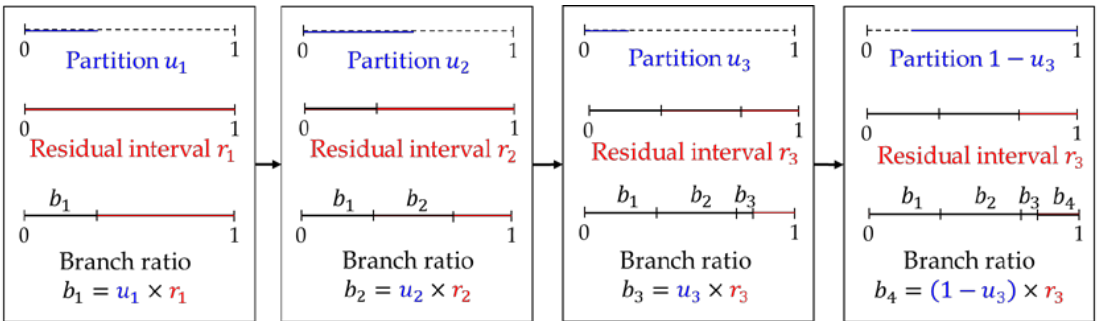
Figure 1. Schematic illustration of branch ratio random partition (branch ratio value is taken as partitioned interval, , with the partition being randomly selected between zero and unity).